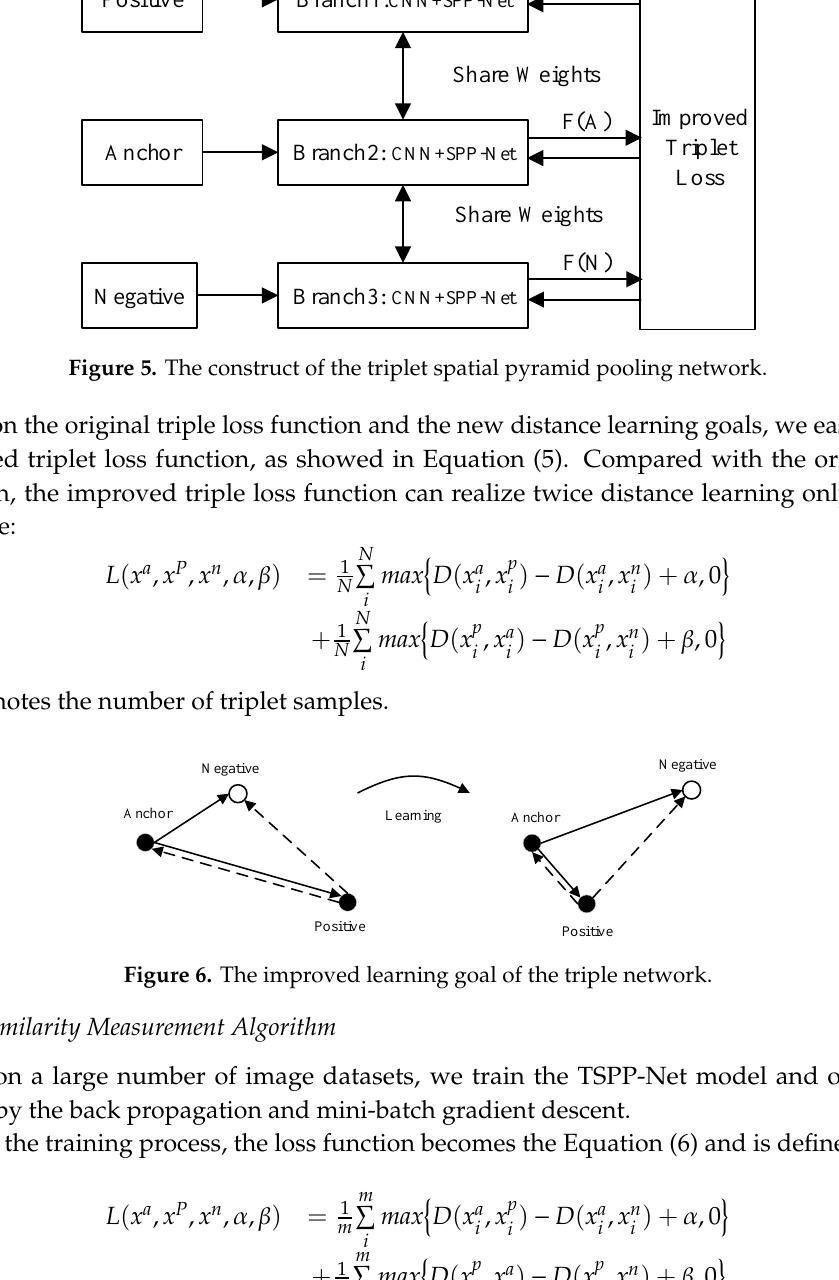
Figure 6. The improved learning goal of the triple network.